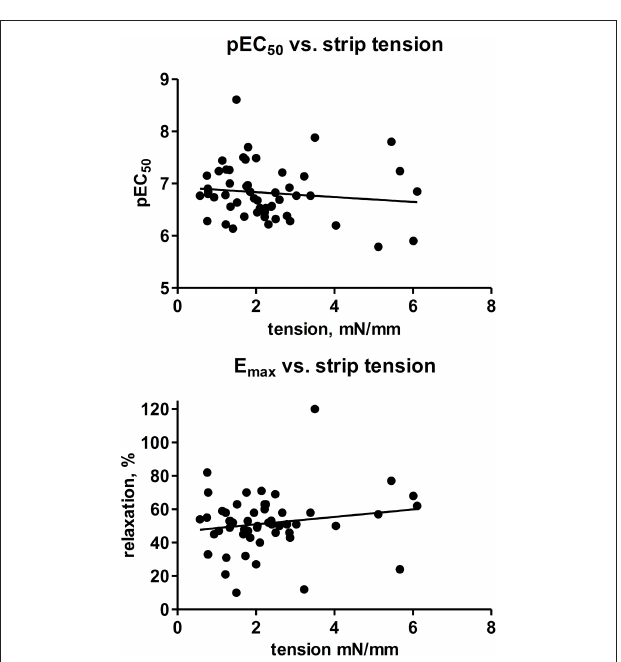
Figure 6 | effect of type of contractile stimulus (KCl vs. passive tension) on the potency and efficacy of isoprenaline to relax human detrusor strips. Bars describe group means whereas each data point represents one patient (2–4 strips being tested per patient).